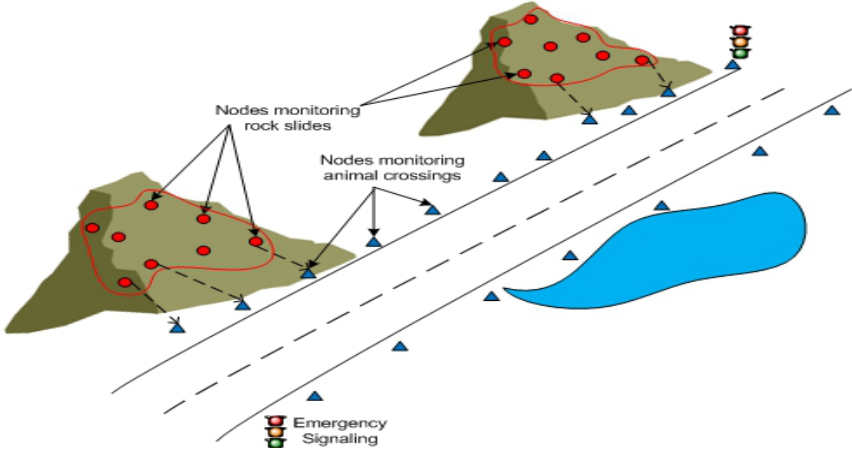
Figure 5. Applications of VSN in rock slide and animal